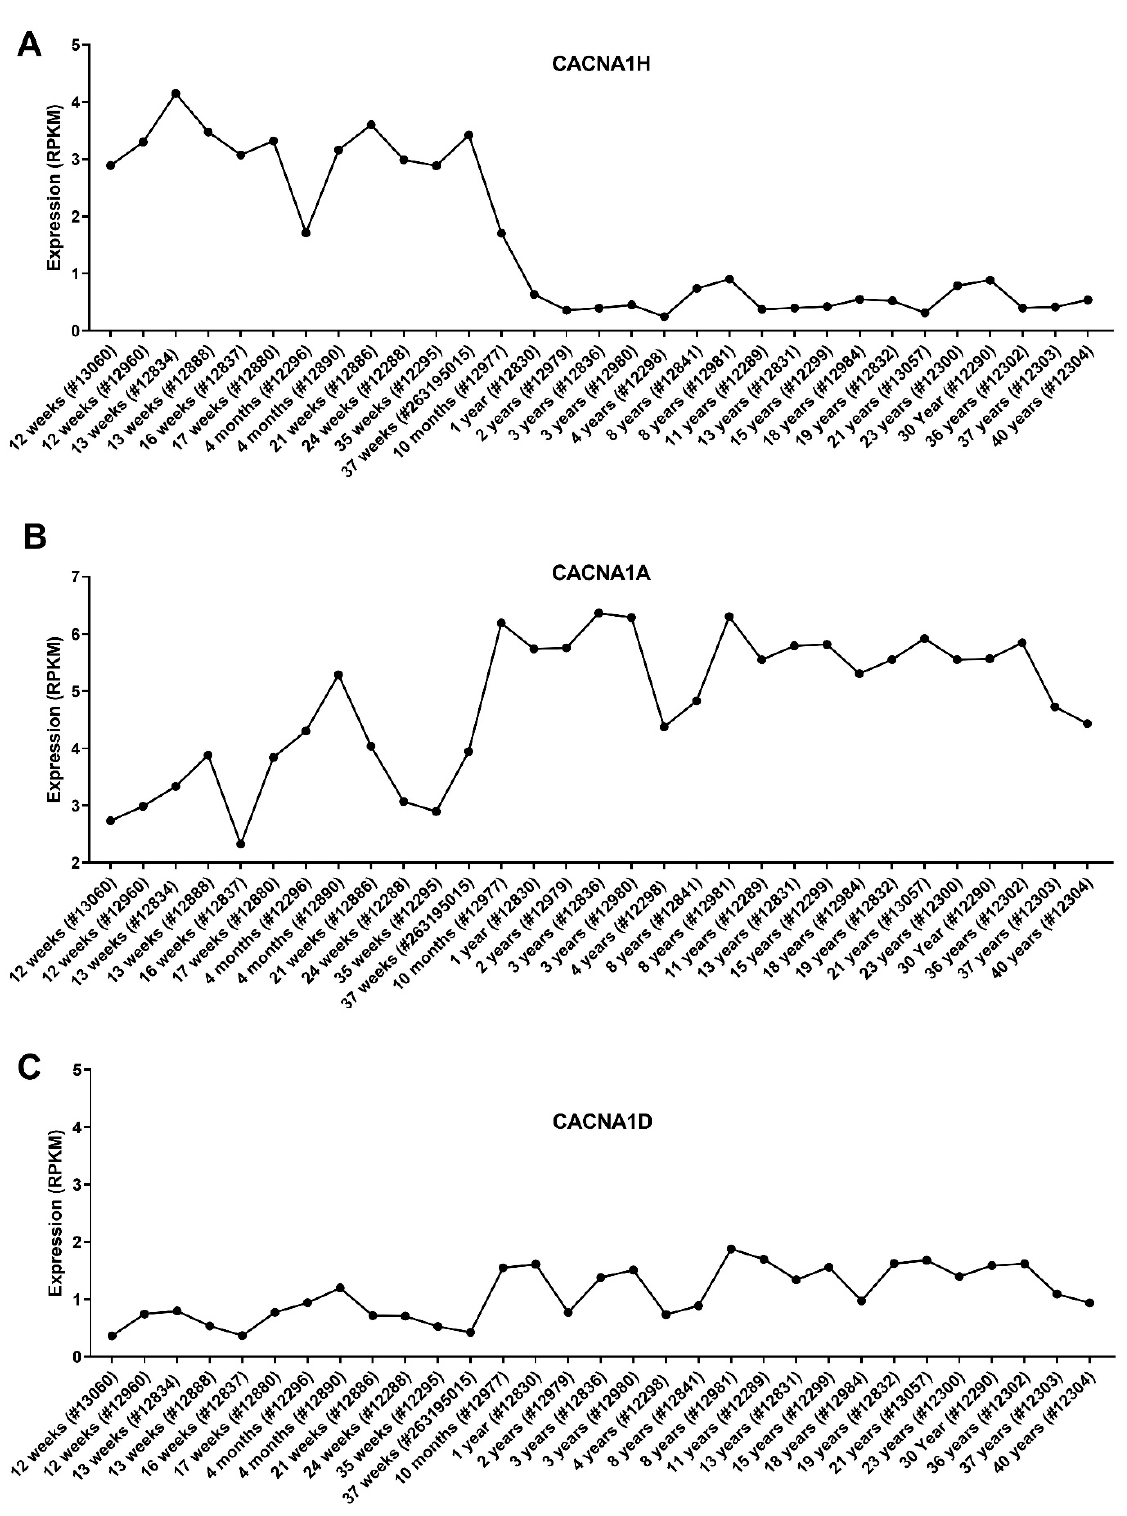
Figure 7. Expression of the CACNA1 genes in the cerebellum of individuals of different ages. Microarray data of the cerebellum of the developing brain were obtained from the BrainSpan Atlas of the Developing Human Brain. A total of 31 cerebellum samples from 12 post-conceptual weeks to 40 years. Expression values of ( A ) CACNA1H, ( B ) CACNA1A and ( C ) CACNA1D are shown in RPKM. Donor ID for each sample is stated in the